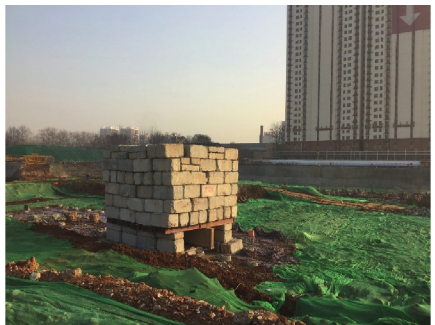
Figure 5: Compressive static load test.